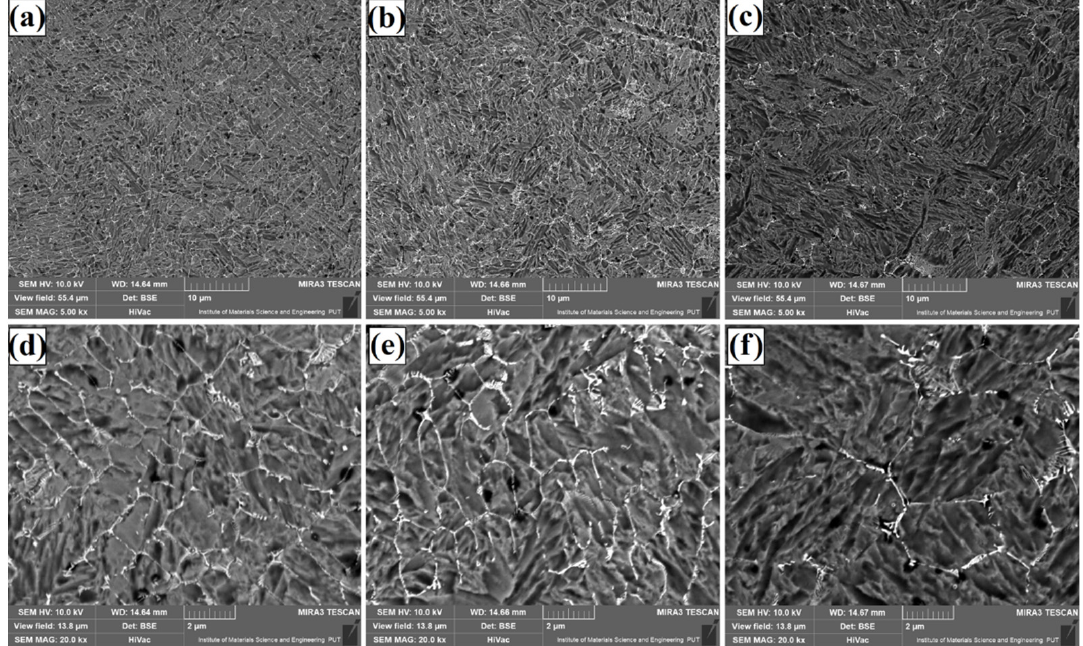
Figure 4. Subsurface area of the Fe/TaC coatings produced on tool steel using 30 µm thick pre-coat and laser beam power of 500 W ( a , d ), 800 W ( b , e ), 1100 W ( c , f ).